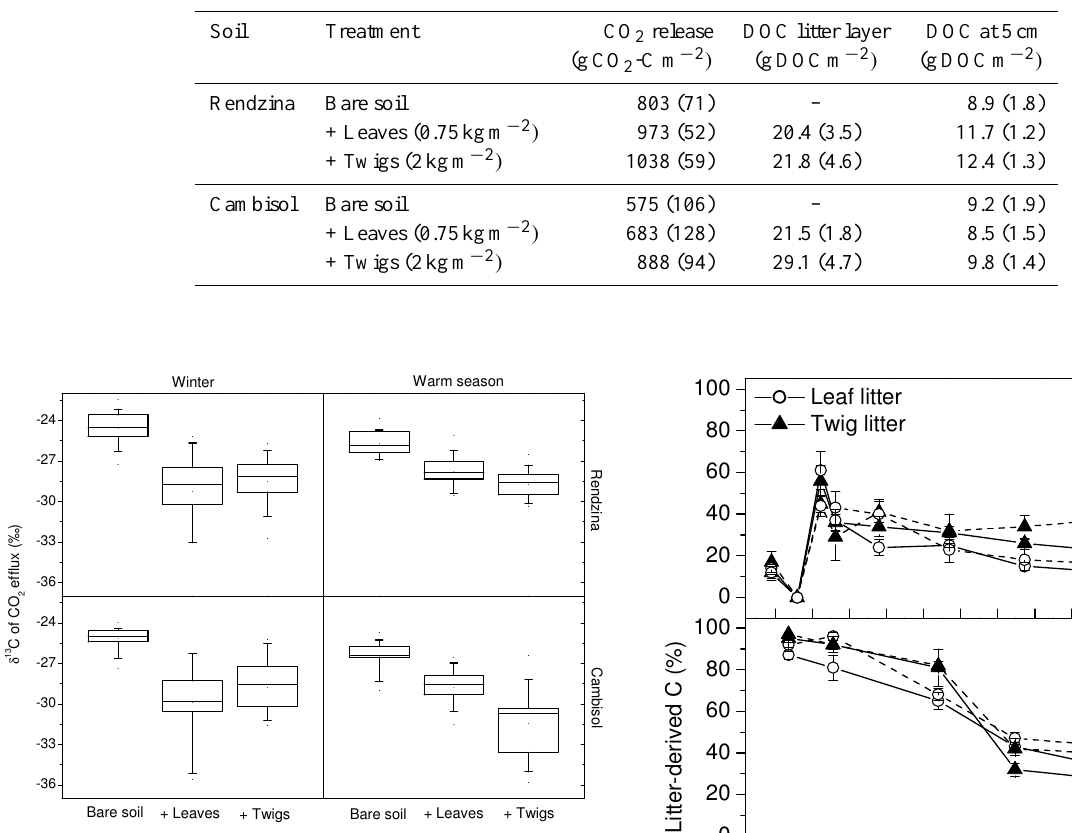
Fig. 3. Variability in the δ 13 C of the soil CO 2 efflux. Each box shows the median value, the quartiles and the 2.5%- and 97.5%-quantiles of 25 single measurements in the winter (Nov 3